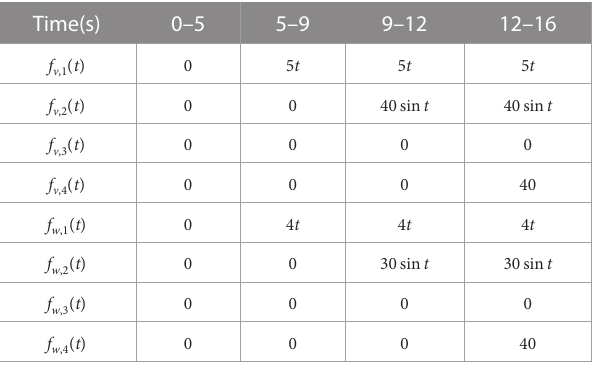
Frontiers in Energy